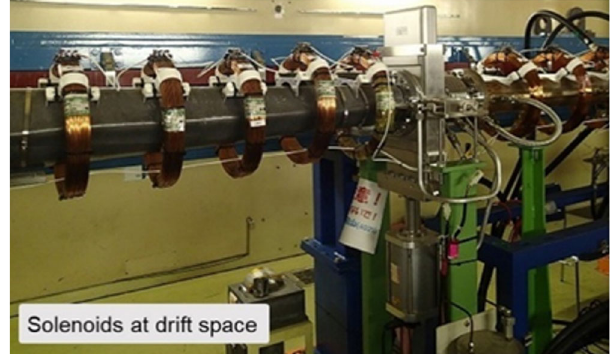
FIG. 9. Solenoids at drift spaces.